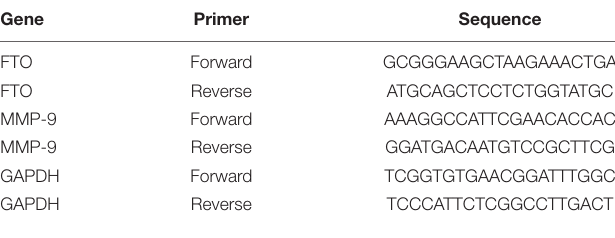
TABLE 1 | Sequences of primers